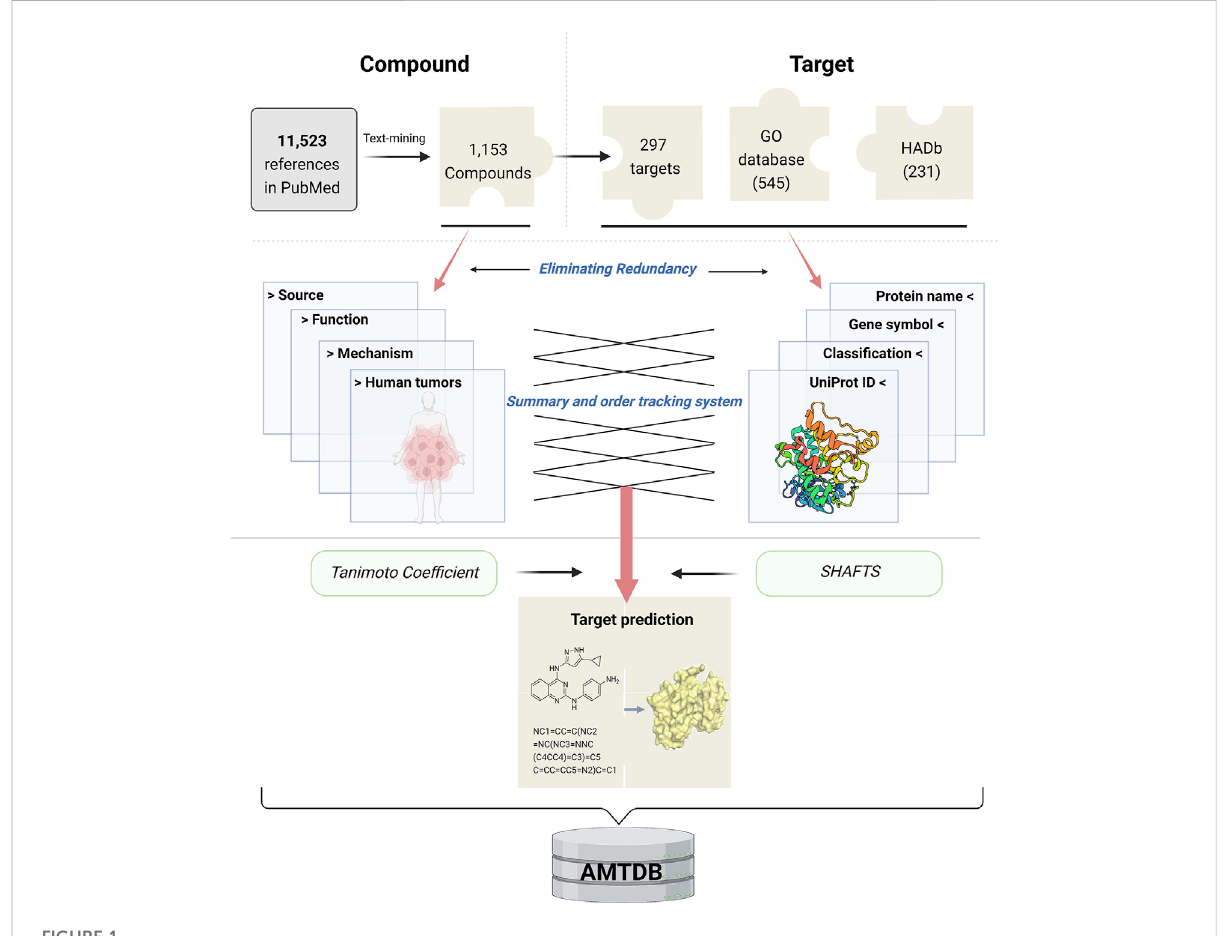
FIGURE 1 A logical framework of